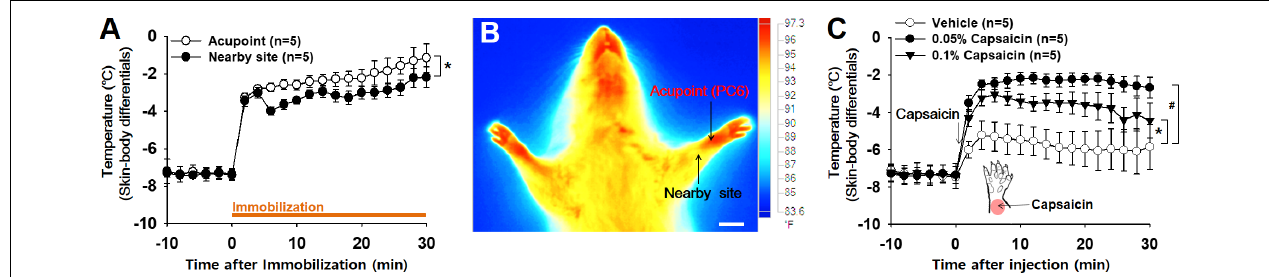
FIGURE 2 | Increased temperature at acupoints in IMH rats. (A) Changes in temperature at acupoints on the wrist following restraint. Skin (acupoint)-body temperature differentials were calculated by subtracting the body temperatures from the temperatures over wrist acupoints. ∗ p < 0.05 vs. nearby site. (B) A